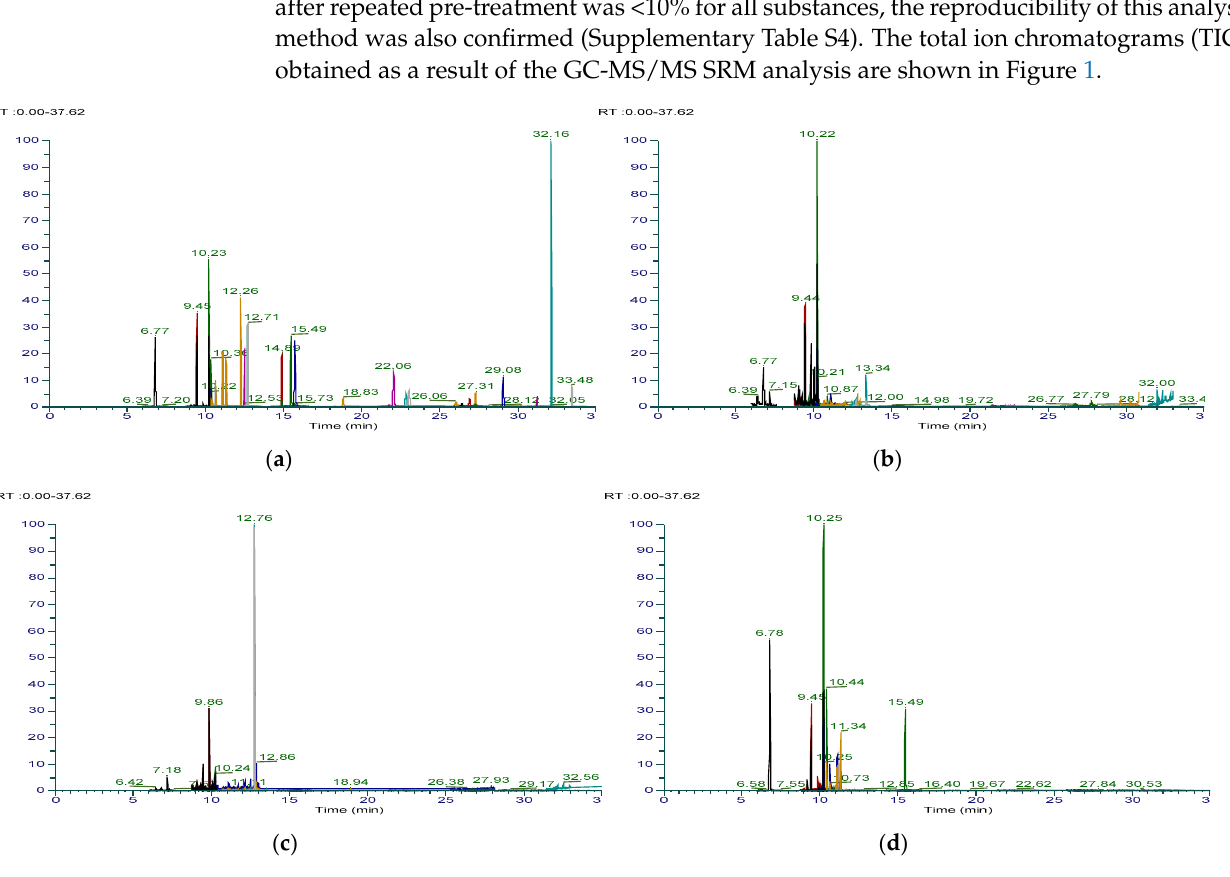
Figure 1. TIC of SRM of GC-MS/MS analysis: ( a ) standard mixture; ( b ) tobacco extraction solution; ( c ) filter tip extraction solution; ( d ) capsule extraction solution.